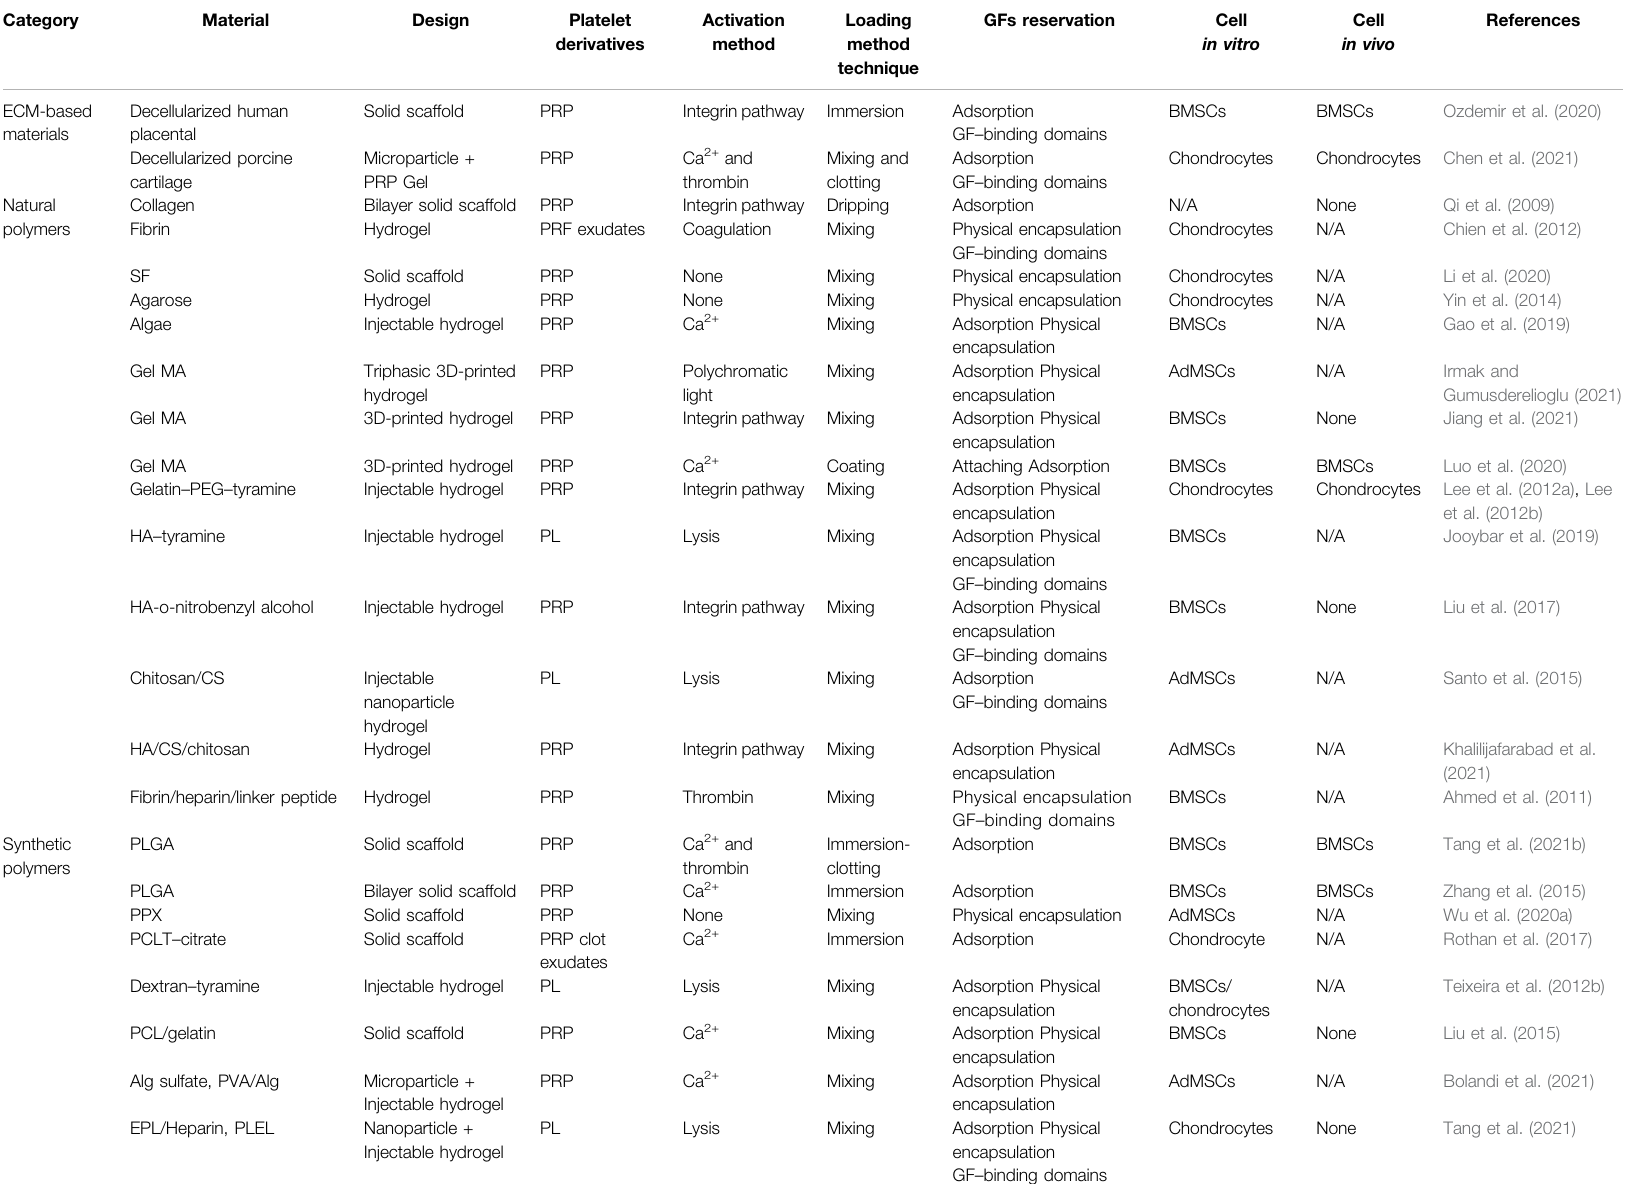
TABLE 1 | Designs of CTE constructs with platelet derivatives in the